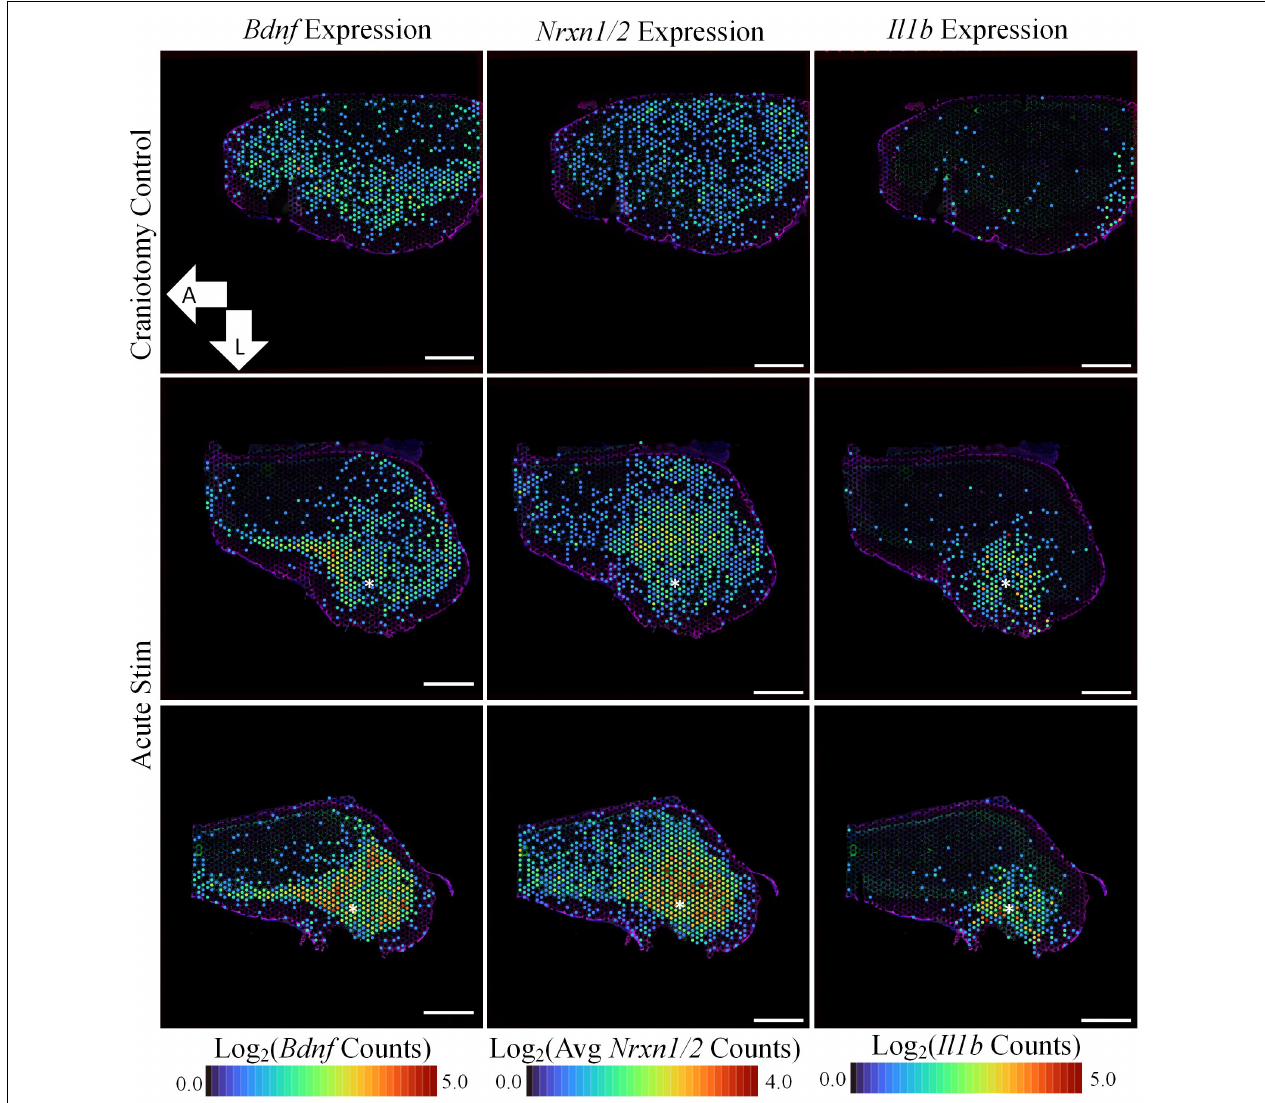
FIGURE 3 | Acute stimulation is associated with upregulation of plasticity-associated genes. In addition to inflammation-associated genes, device insertion and stimulation caused the upregulation of genes associated with synaptic transmission. Bdnf , Nrxn1 , and Nrxn2 are all implicated in the formation and maintenance of synapses, and each were more prominently expressed in the stimulated samples in comparison to craniotomy control. Asterisks denote estimated implant site and arrows denote orientation (L: lateral, A: anterior). Scale bars: 1.0